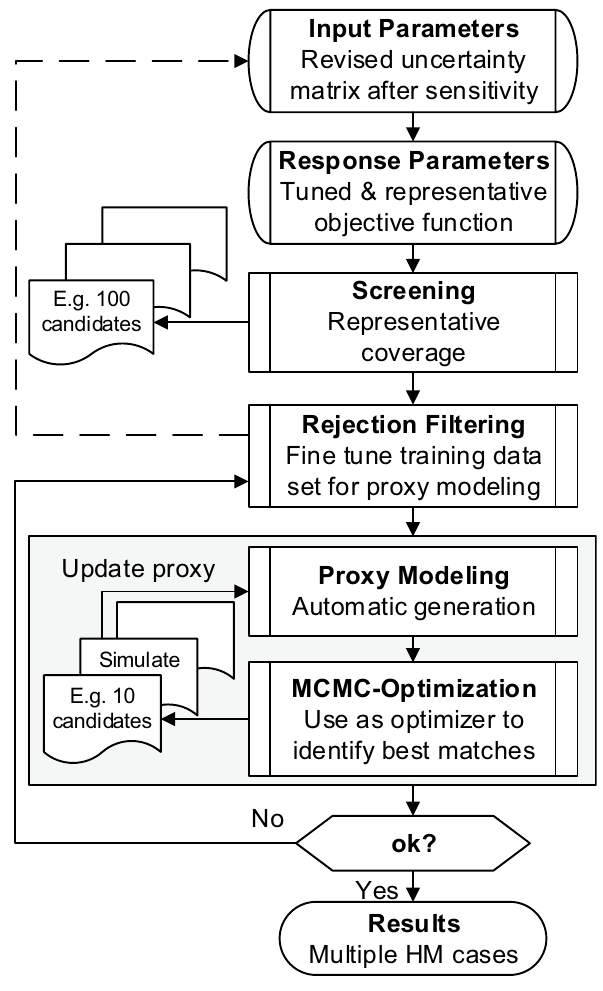
Fig. 5 History Matching supported by MCMC techniques Fig. 6 Multi‑objective criteria shown as staged‑bar‑plot (left) and cross‑plot